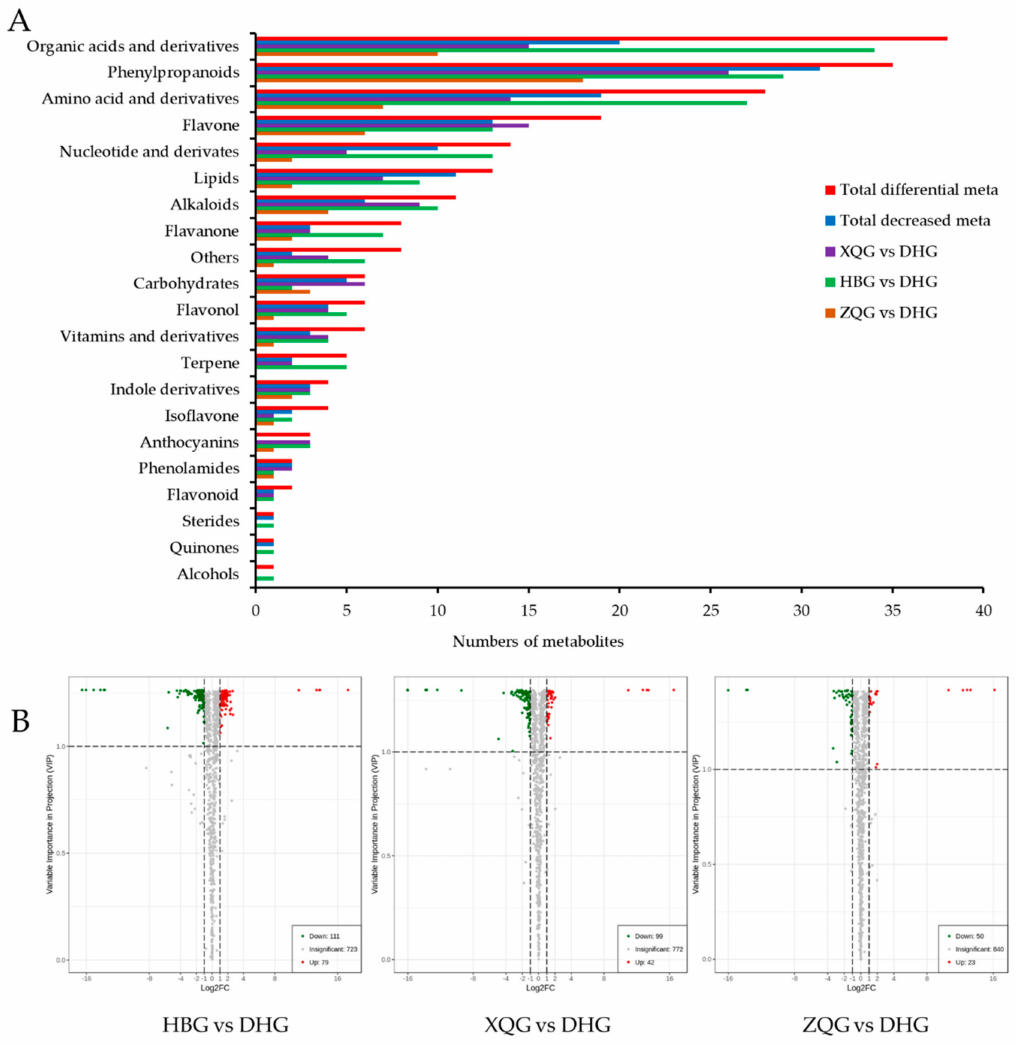
Figure 5. Number of di ff erent types of di ff erential metabolites ( A ) and volcano plots of di ff erential metabolites ( B ) of the tree comparison